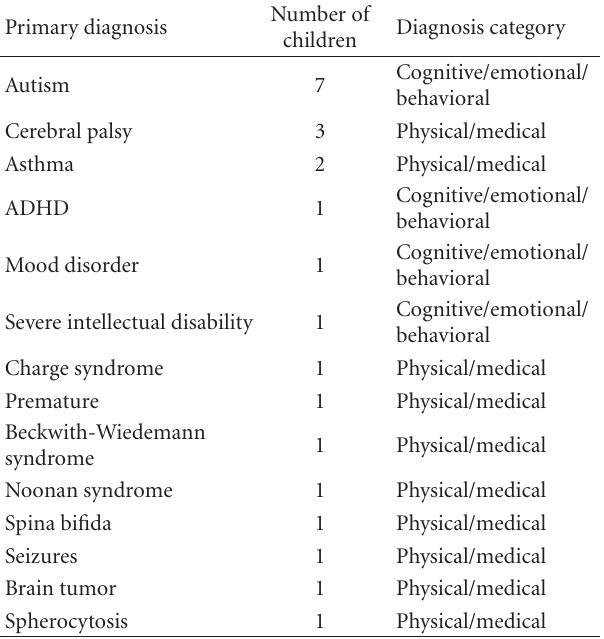
Table 2: Primary diagnoses and diagnostic